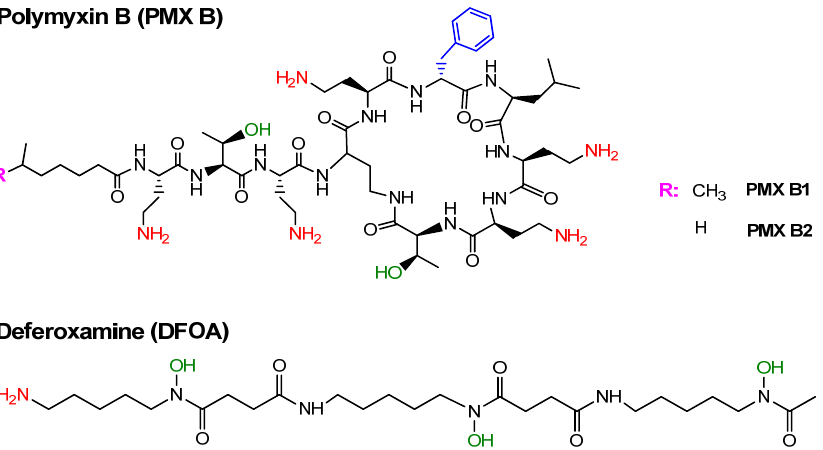
Figure 1. Structures of polymyxin B and deferoxamine used for conjugation with synthetic polymers. Polymyxin B used in this study was a mixture of homologues B1 (81.5%) and B2 (18.5%).